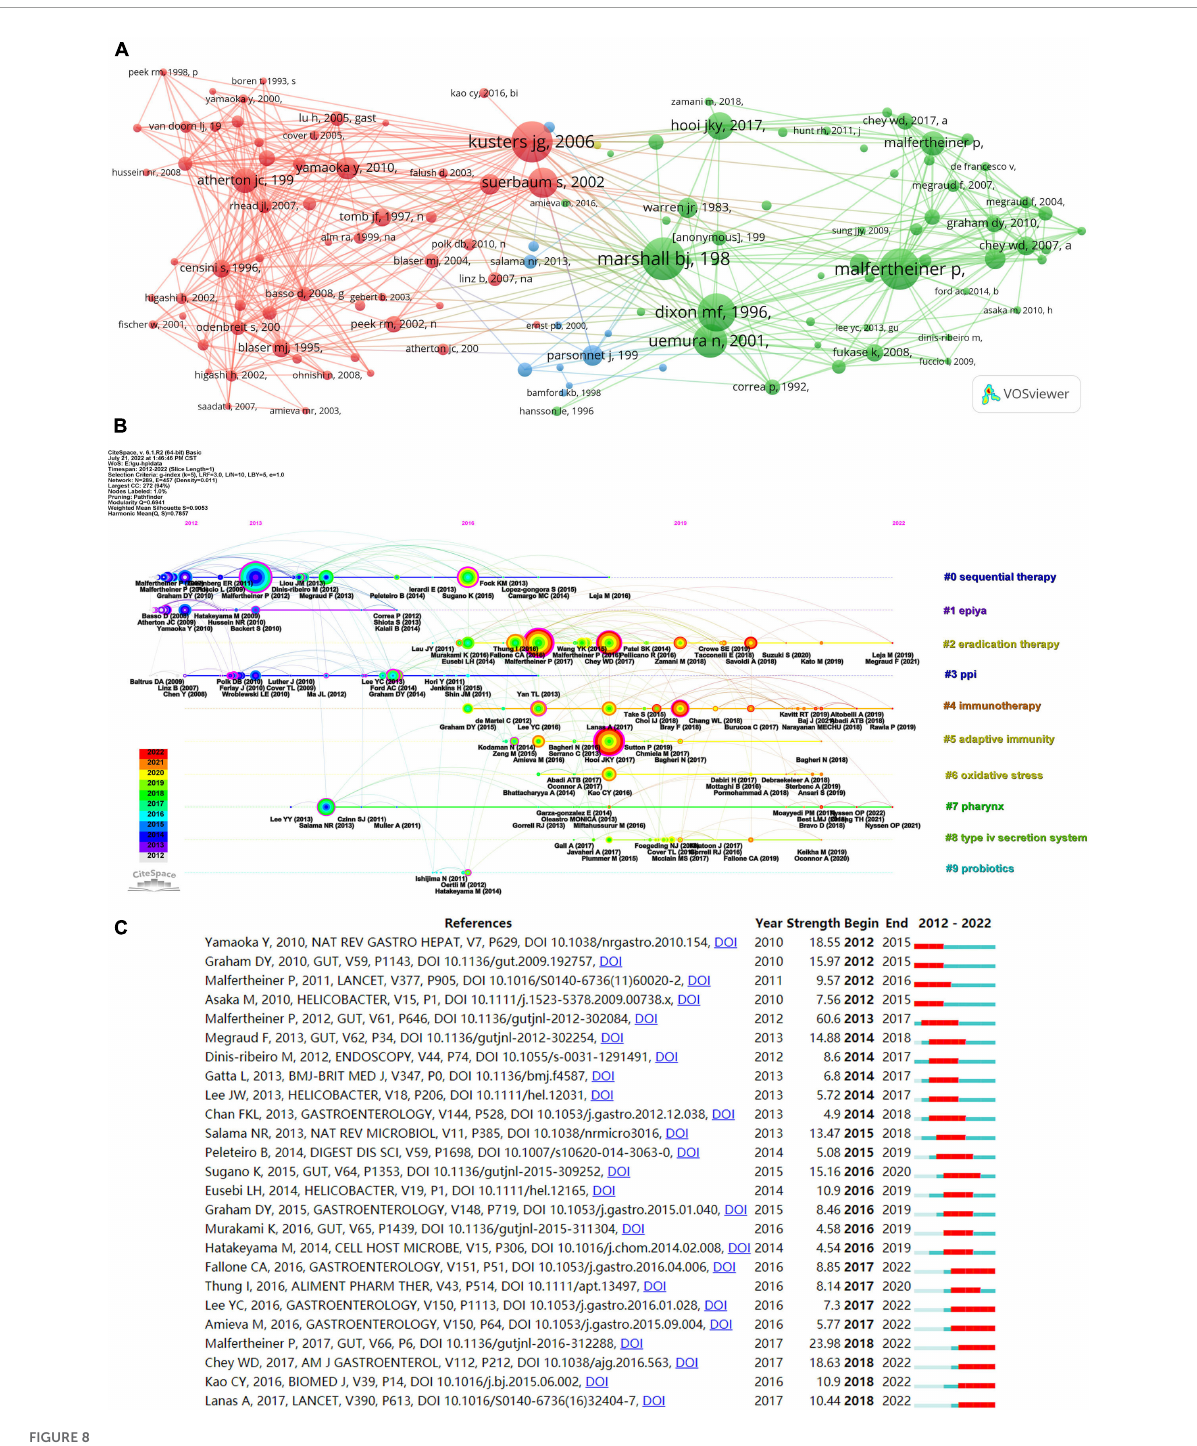
FIGURE8 The co-cited references map on Helicobacter pylori -related gastric ulcer (GU). (A) The network for co-cited references. (B) The timeline view for co-cited references. (C) The top 25 co-cited references with the strongest citation bursts.